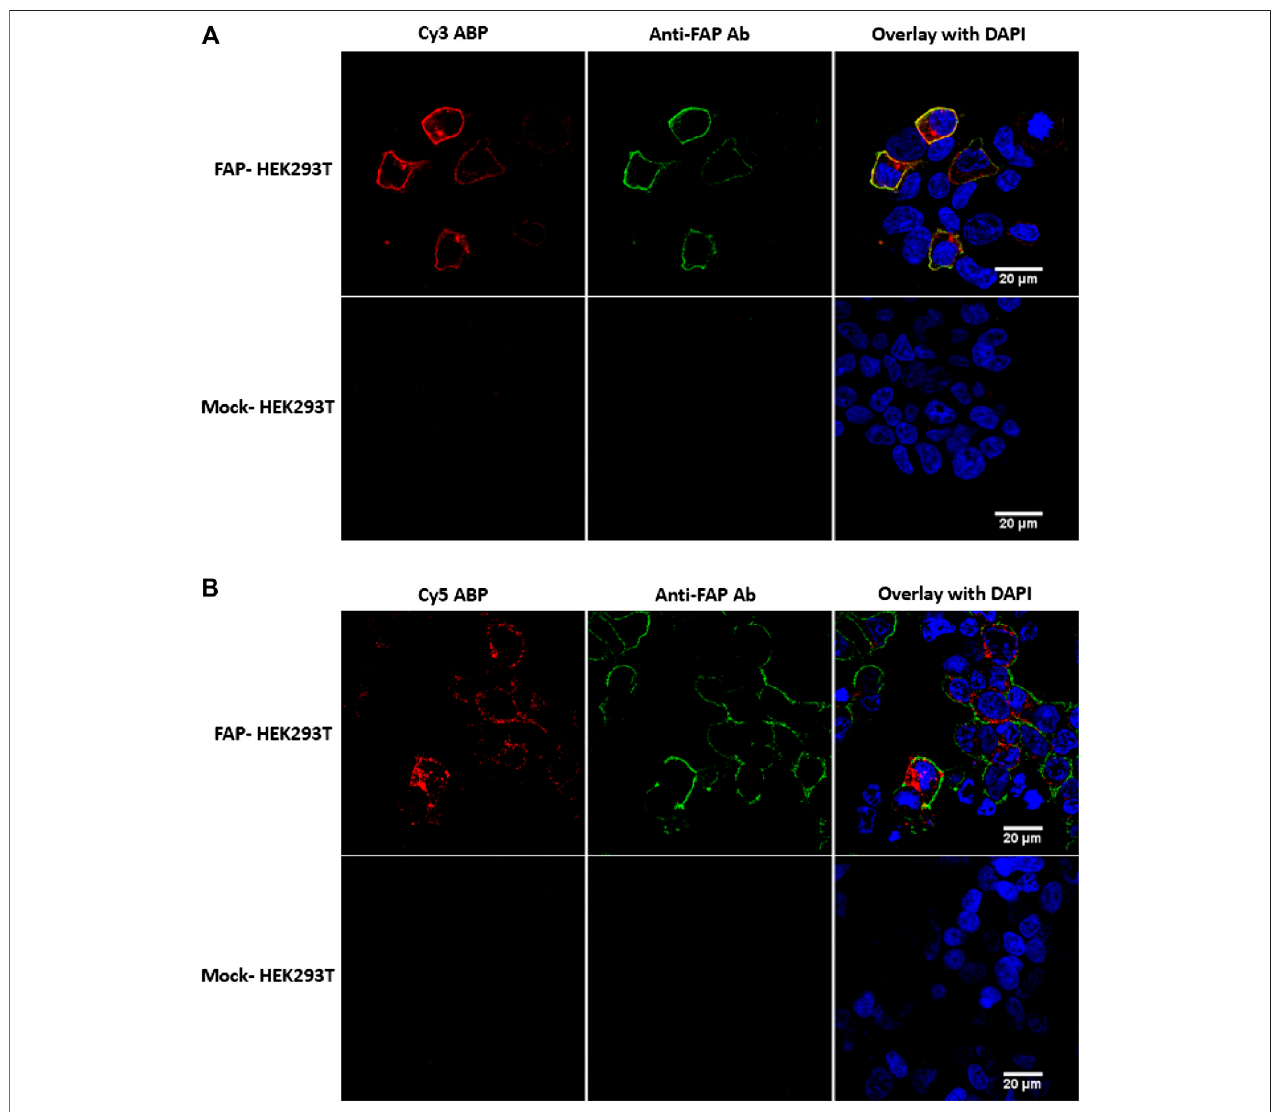
FIGURE4 | FAP activity labelingwith probes 6 (Cy3-labeled)and 7 (Cy5-labeled)in FAP-transfectedHEK293Tcells. (A) Clear membrane colocalization ofthe Cy3 probe (red) and the F19 anti-FAP antibody (green), indicating selectivity of the fl uorescent Cy3 probe. (B) The Cy5 probe caused cytoplasmatic staining, whereas the antibody is mainly visible at the membrane, suggesting an internalization of the FAP-Cy5 complex. No aspeci fi c stainings were visible in the mock-transfected HEK293T cells. Images are representative of at least two independent experiments ( n (cid:2) 2).